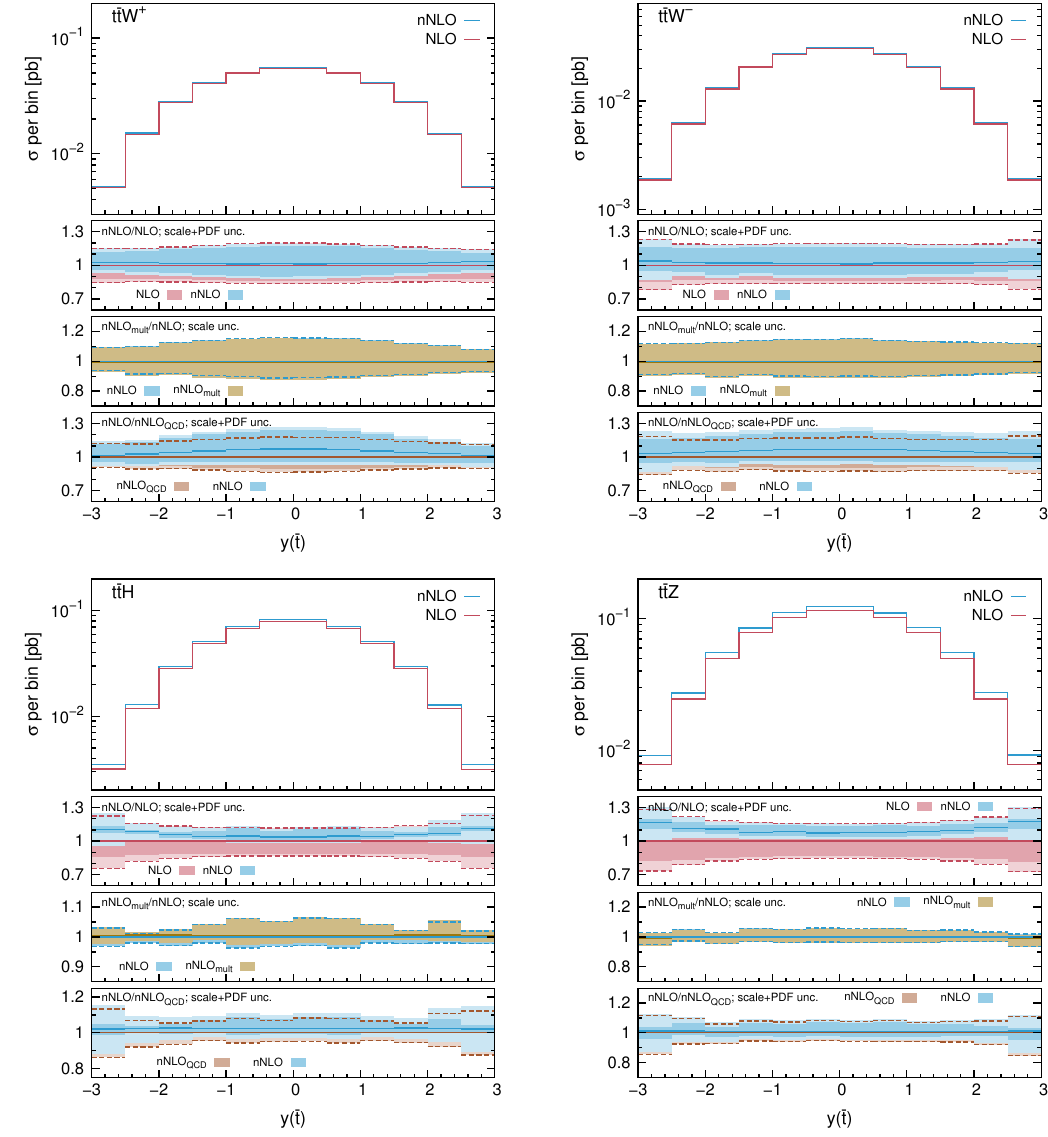
Figure 8 . Distributions di(cid:11)erential w.r.t. the antitop-quark rapidity Same structure as in (cid:12)gure 7. After considering theoretical uncertainties related to the choice of PDFs and to